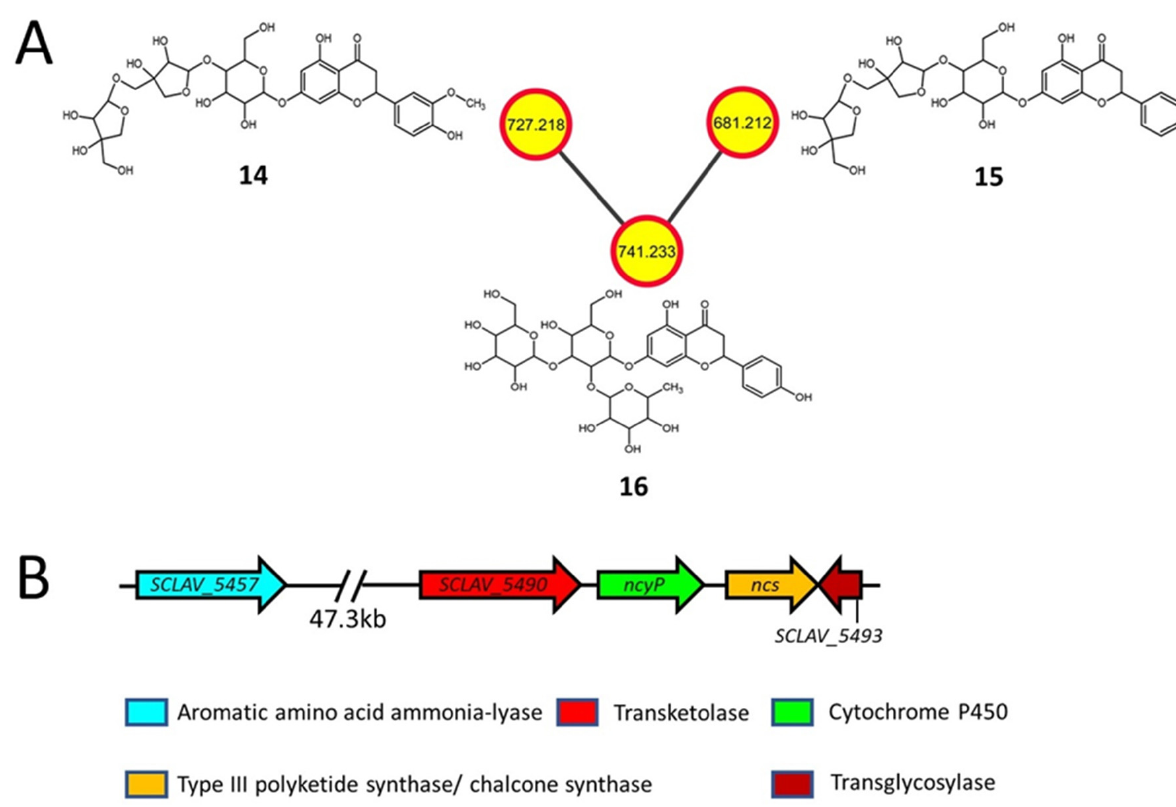
Figure 3. Molecular network (negative ionization mode) and associated biosynthetic gene cluster (BGC) for flavonoid glycosides detected in S. clavuligerus strains overexpressing the K88E variant of rpsL ( A ) In silico structure prediction of metabolites using GNPS-based molecular networking and network annotation propagation (NAP). Each node depicts a mass spectrum (labeled with m/z of the respective precursor mass) and edges represent the relationship between different nodes. The top-ranked NAP-consensus structural predictions (red boundary) present in the S. clavuligerus strain overexpressing the K88E variant of rpsL (yellow fill) are shown. ( B ) The proposed BGC in S. clavuligerus associated with the biosynthesis of flavonoid glycosides, including the previously reported genes required for naringenin (flavonoid) produc- tion.